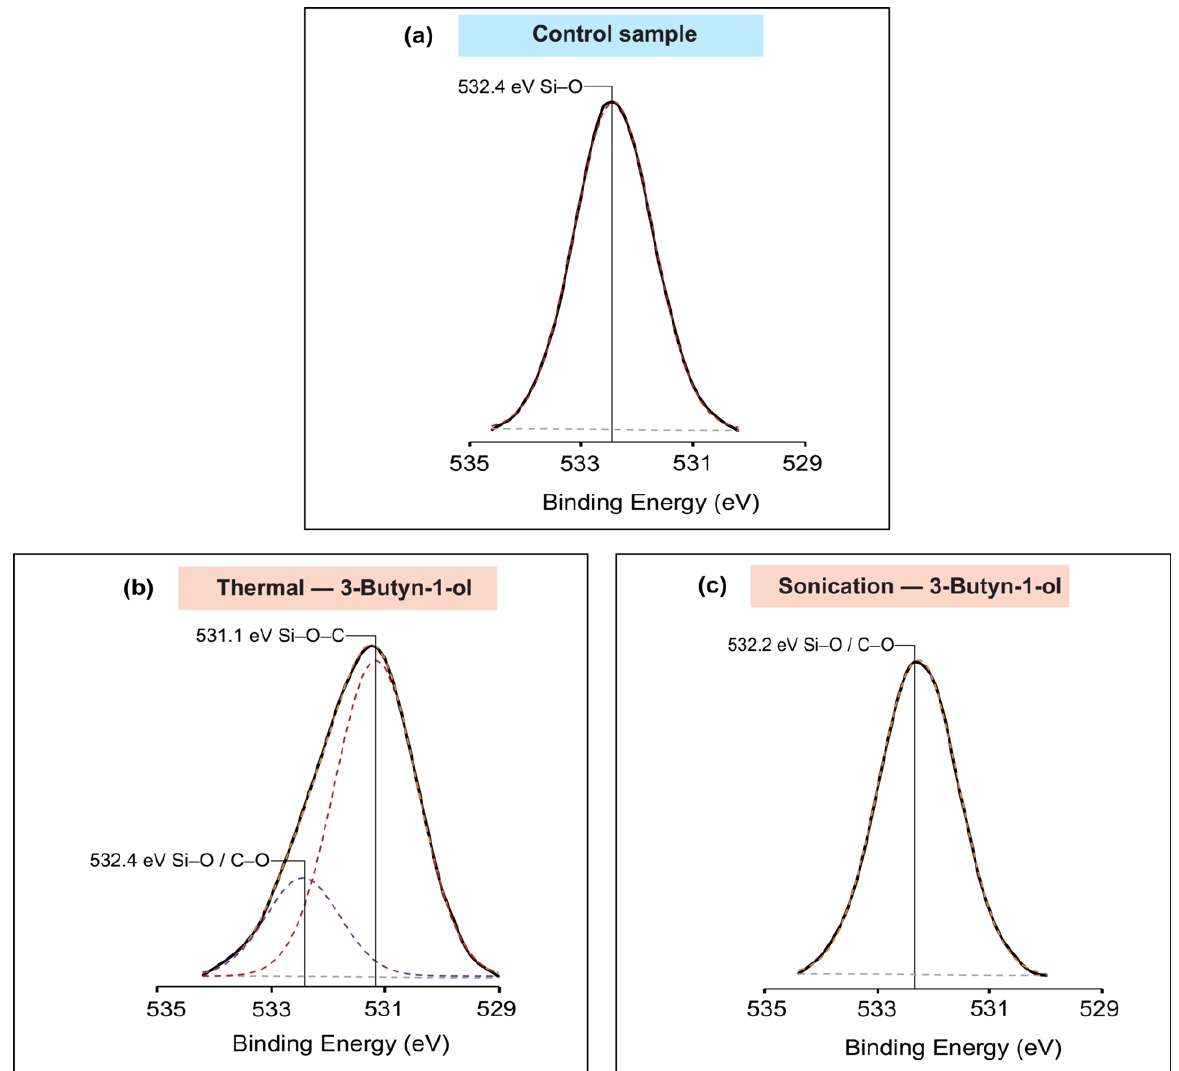
Figure 4. Deconvolution of the high-resolution O1s spectra ( a ) control sample; ( b ) thermal reaction of 3-Butyn-1-ol with two peaks observed at 531.1 and 532.4 eV; ( c ) sonochemical reaction of 3-Butyn-1-ol.